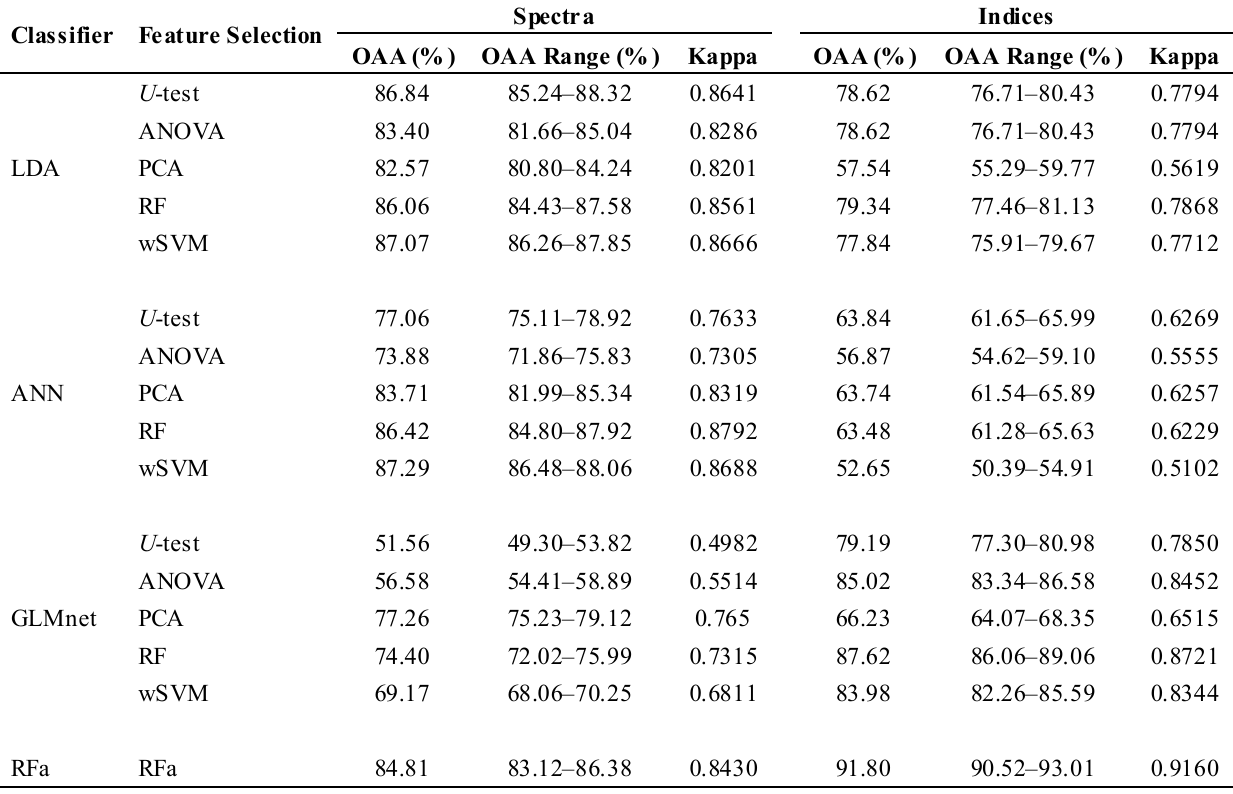
Table 3. Summary of species identification accuracies using linear discriminant analysis (LDA), artificial neural network (ANN), generalized linear models with an elastic net regularization (GLMnet) and random forest (RFa) algorithms with spectral wavebands and